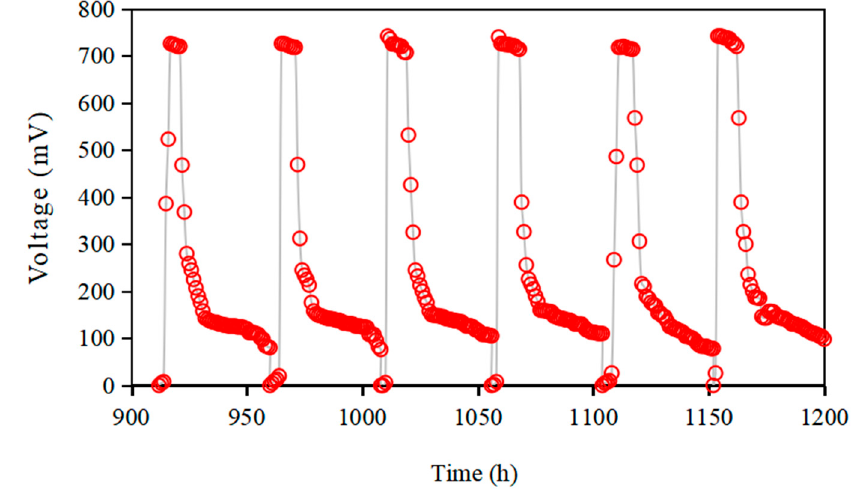
Figure 6. Voltage output versus time in the AMDC with coastal saline-alkaline soil-washing water.